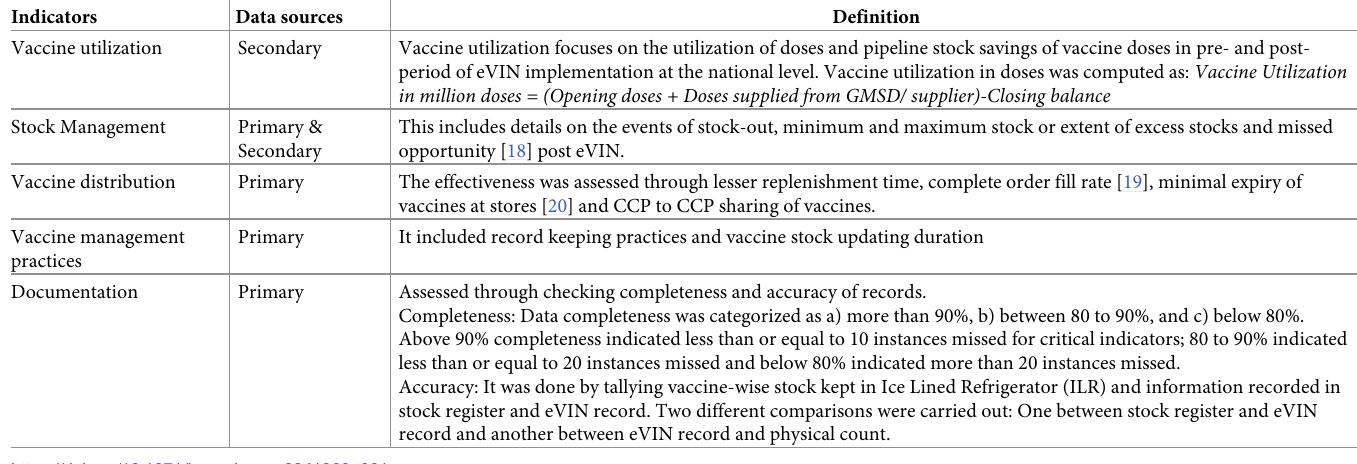
Table 1. List of programmatic assessment indicators, data sources and definition